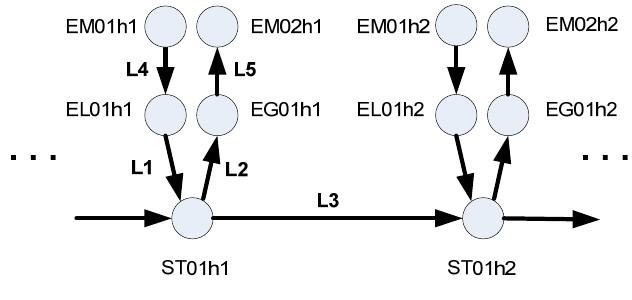
Figure 3. Energy storage system